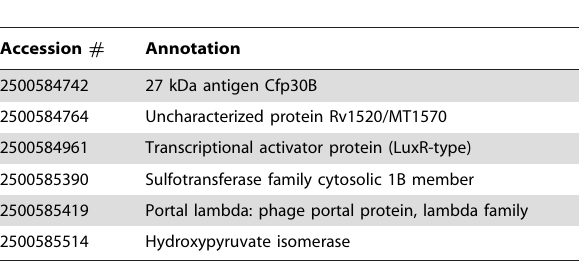
Table 5. Unique proteins with functional annotation encoded by the genomes of strains R11 and